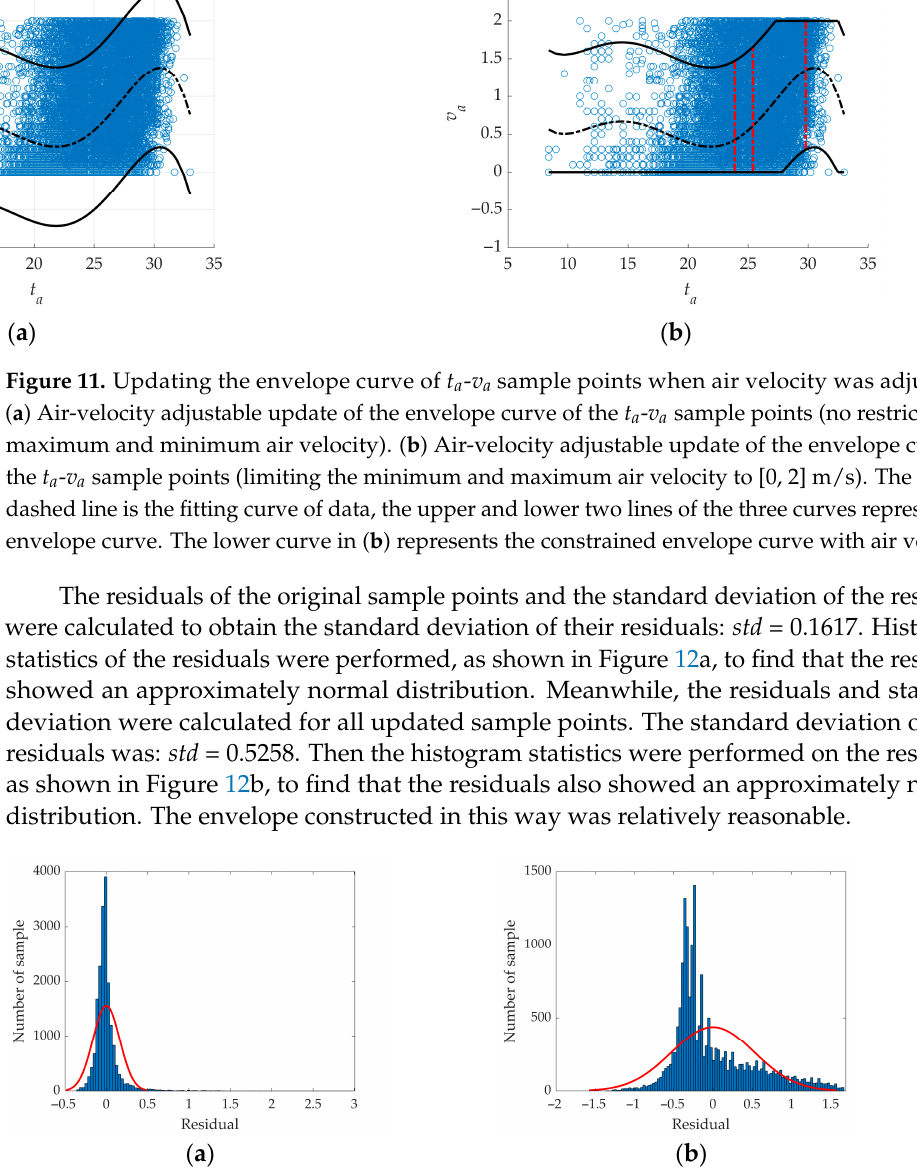
Figure 12. Histogram statistics of residuals for adjustable air-velocity sample points. ( a ) Residual histogram statistics for raw sample points of adjustable air velocity. ( b ) Residual histogram statistics for updated sample points with adjustable air